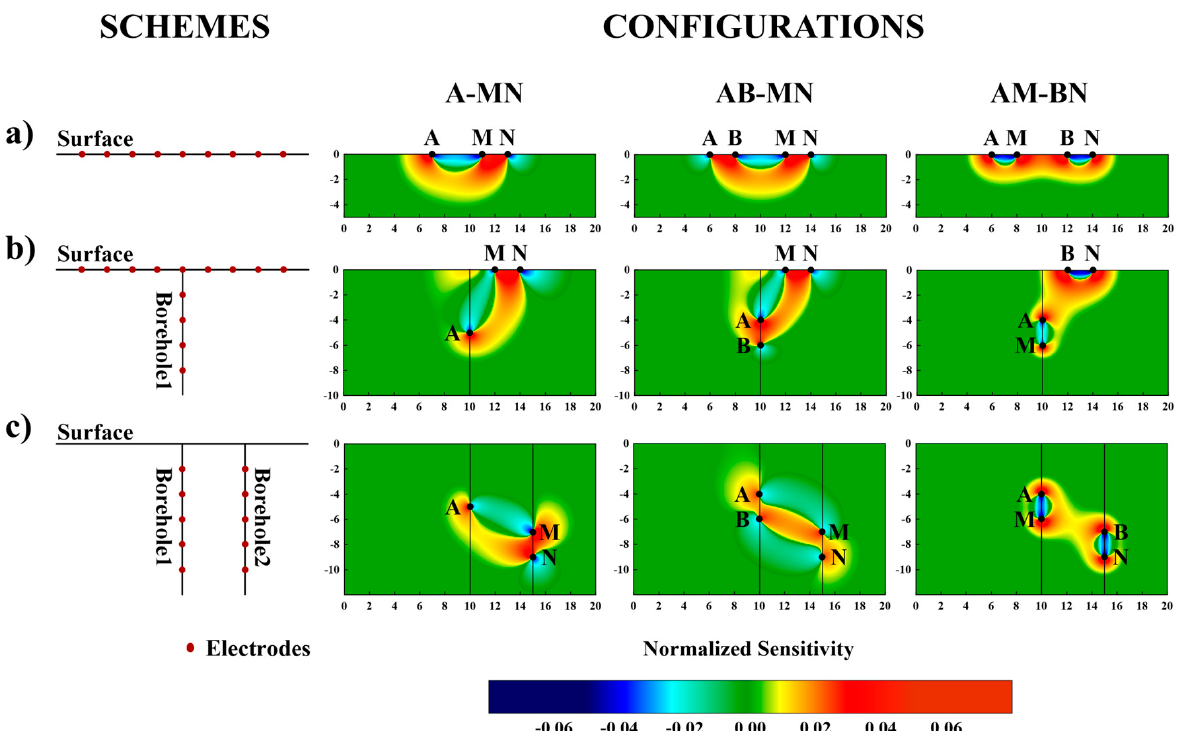
Figure 1. Electrode spatial distribution and sensitivity of three traditional ERT schemes. Row ( a ) represents the surface ERT scheme. Row ( b ) represents the BS-ERT scheme. Row ( c ) represents the CH-ERT scheme. A and B represent the positive and negative current electrodes, respectively. M and N represent the potential electrodes.